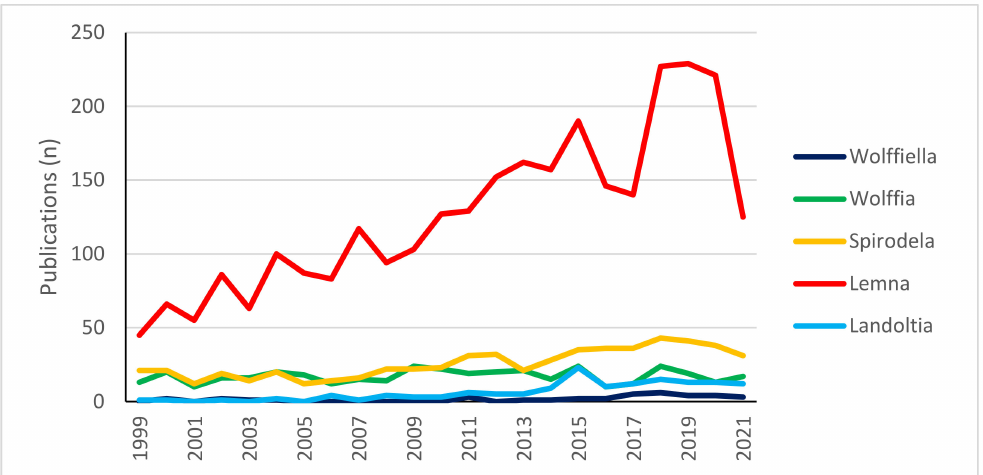
Figure 1. The number of scientific publications per genus of the family Lemnaceae from 1999 to date. Data show the discrepancy between the number of publications for the genus Lemna compared to others. Data are from https: //www.scopus.com (last searched on 23 July 2021) using the name of each genus as keywords and including only results from 1999 to the date of the